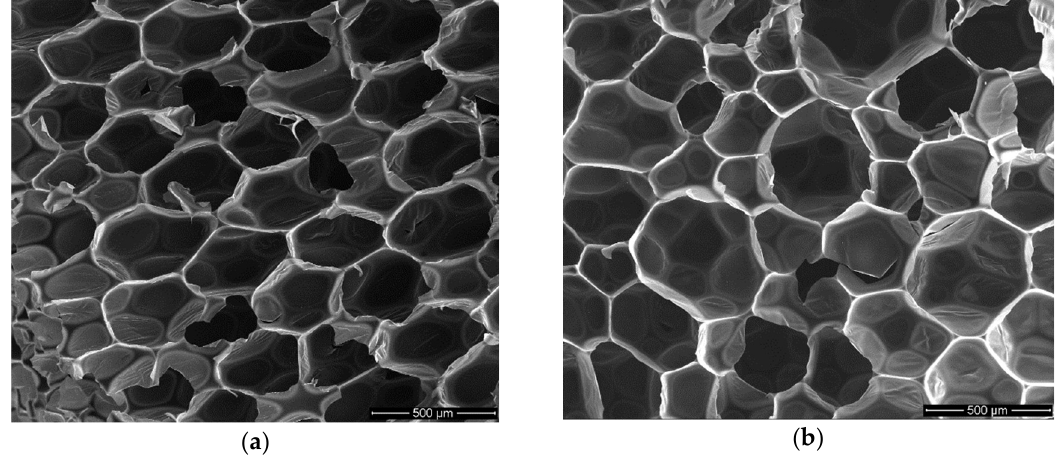
Figure 9. SEM micrographs of ( a ) EPB2.0—reference foam; ( b ) EPB2.4—foam with the highest content of biopolyol.